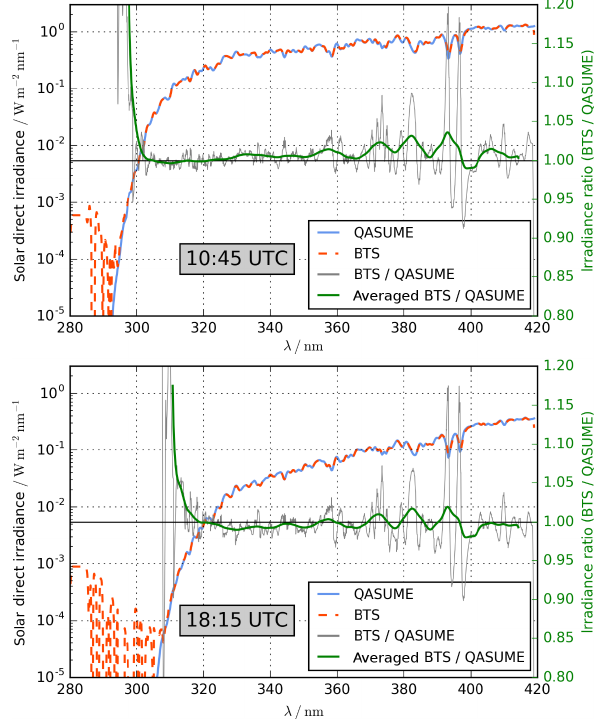
Figure 4. Direct spectral irradiance (blue and red line) measured by the BTS and the double-monochromator-based QASUME instru- ment in Izaña on 20 September, at 10:45UTC and 18:15UTC. The ratio (grey line for single data and green line for moving average) of measurements (right axis) shows satisfactory agreement with av- erage deviations of less than 2.5% between 300 and 420nm for low solar zenith angles at around noontime. The unaveraged ratio (grey line) can be explained by remaining small differences in the opti- cal bandwidth in combination with small wavelength shifts. Due to non-averaging of the BTS data and limited integration time (mea- surement every 8s), noise of the 16 bit ADC in the spectral region below the UV-B solar edge can be observed.